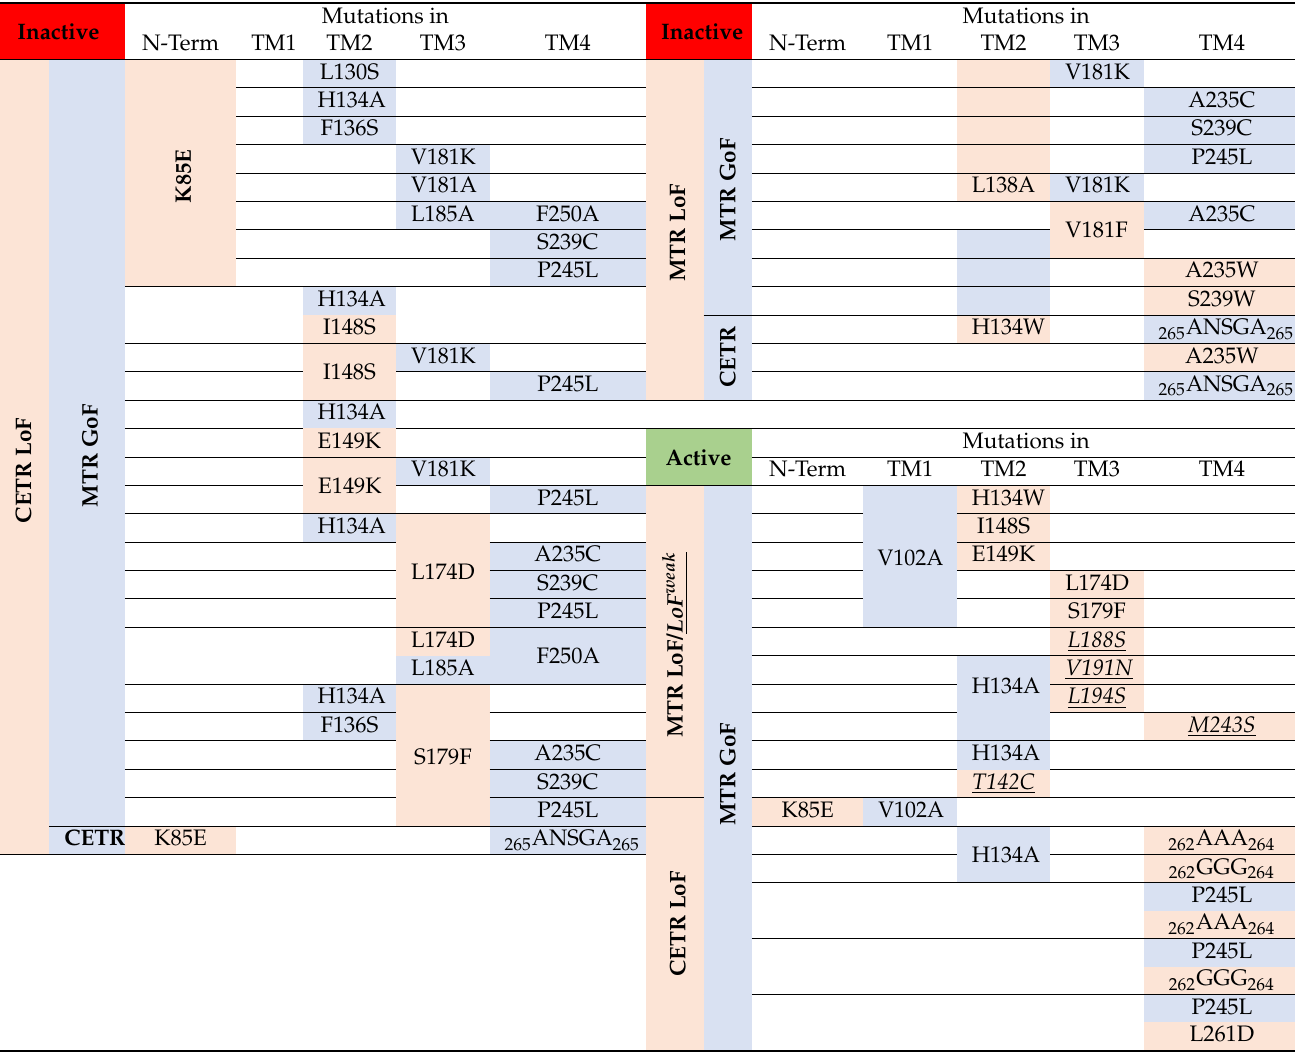
Table 2. Double mutants each combining one GoF and one LoF mutations classified by their effect on constitutive activity. Mutations in Mutations in